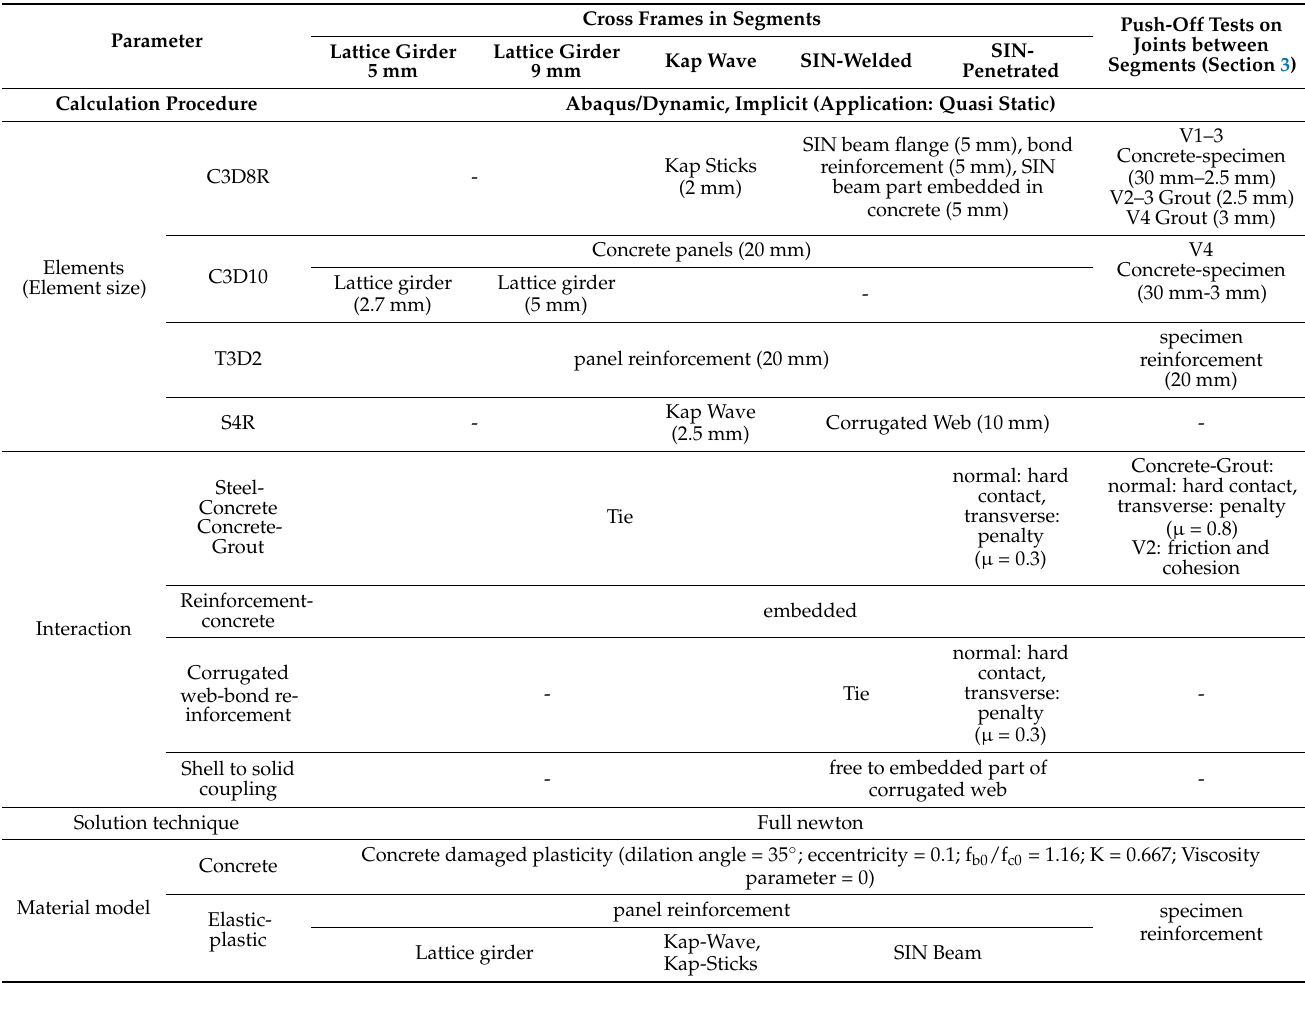
Table 1. Parameters used for the FEA-simulations in the software Abaqus for cross-frames and push-off tests on joints. Parameter